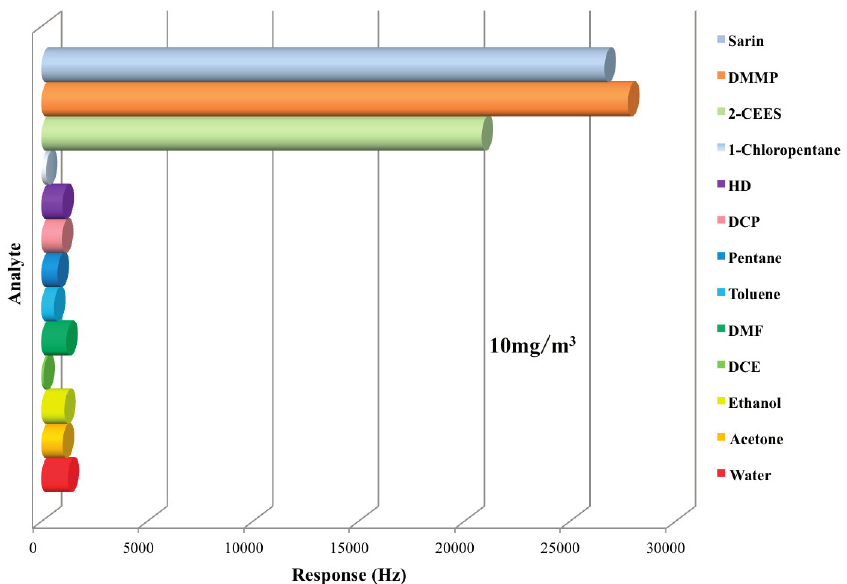
Figure 9. Responses of the PLF sensor to various analytes at 10 mg/m 3